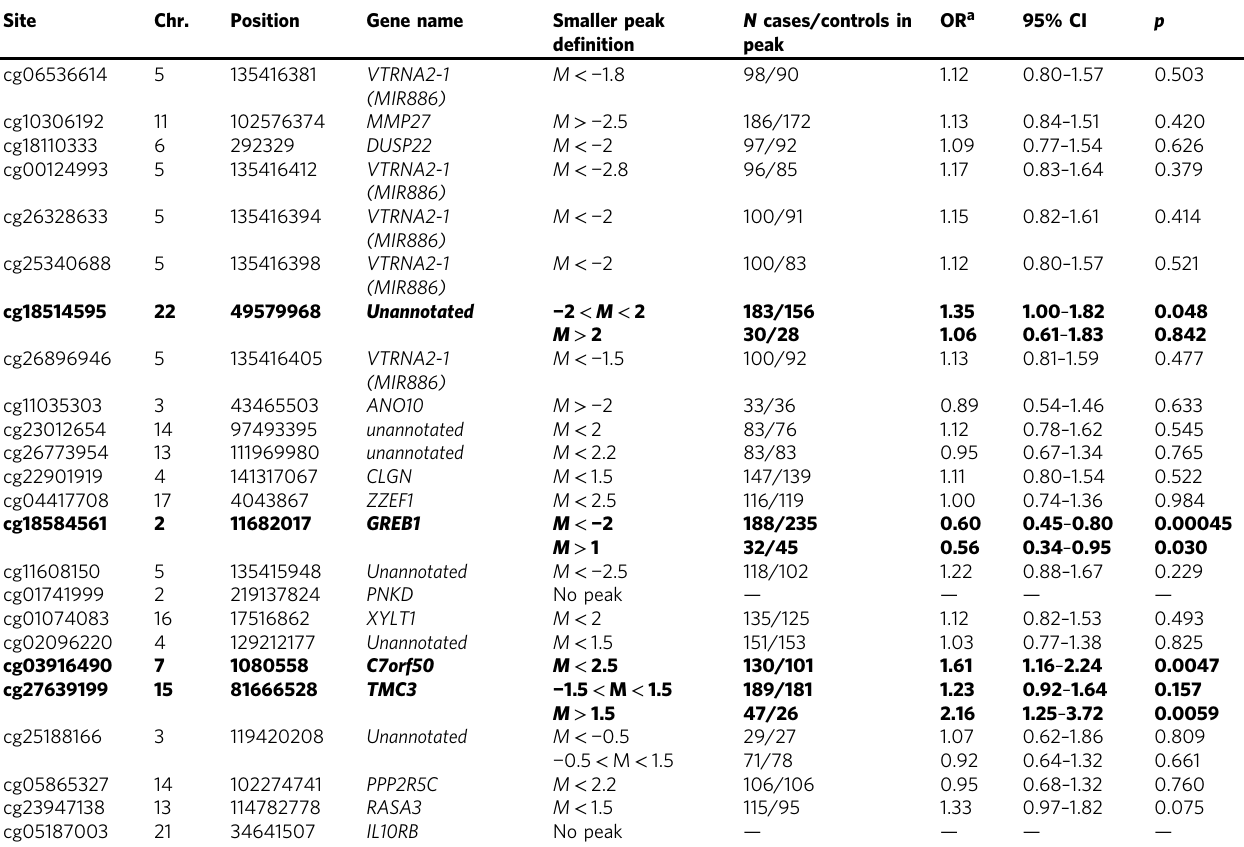
a Odds ratio from conditional logistic regression of the risk of breast canceron M -values (per 1 s.d.), adjusting forbody mass index, tobacco smoking, alcoholdrinking, time between blood collection and cancer diagnosis, and sample type (dried blood spots, peripheral blood mononuclear cells, and buffy coats). Cases and controls were individually matched on year of birth, year of blood draw, country of birth, and sample type for the vast majority of them (97%)). Bold text indicates statistically signi fi cant associations (Table